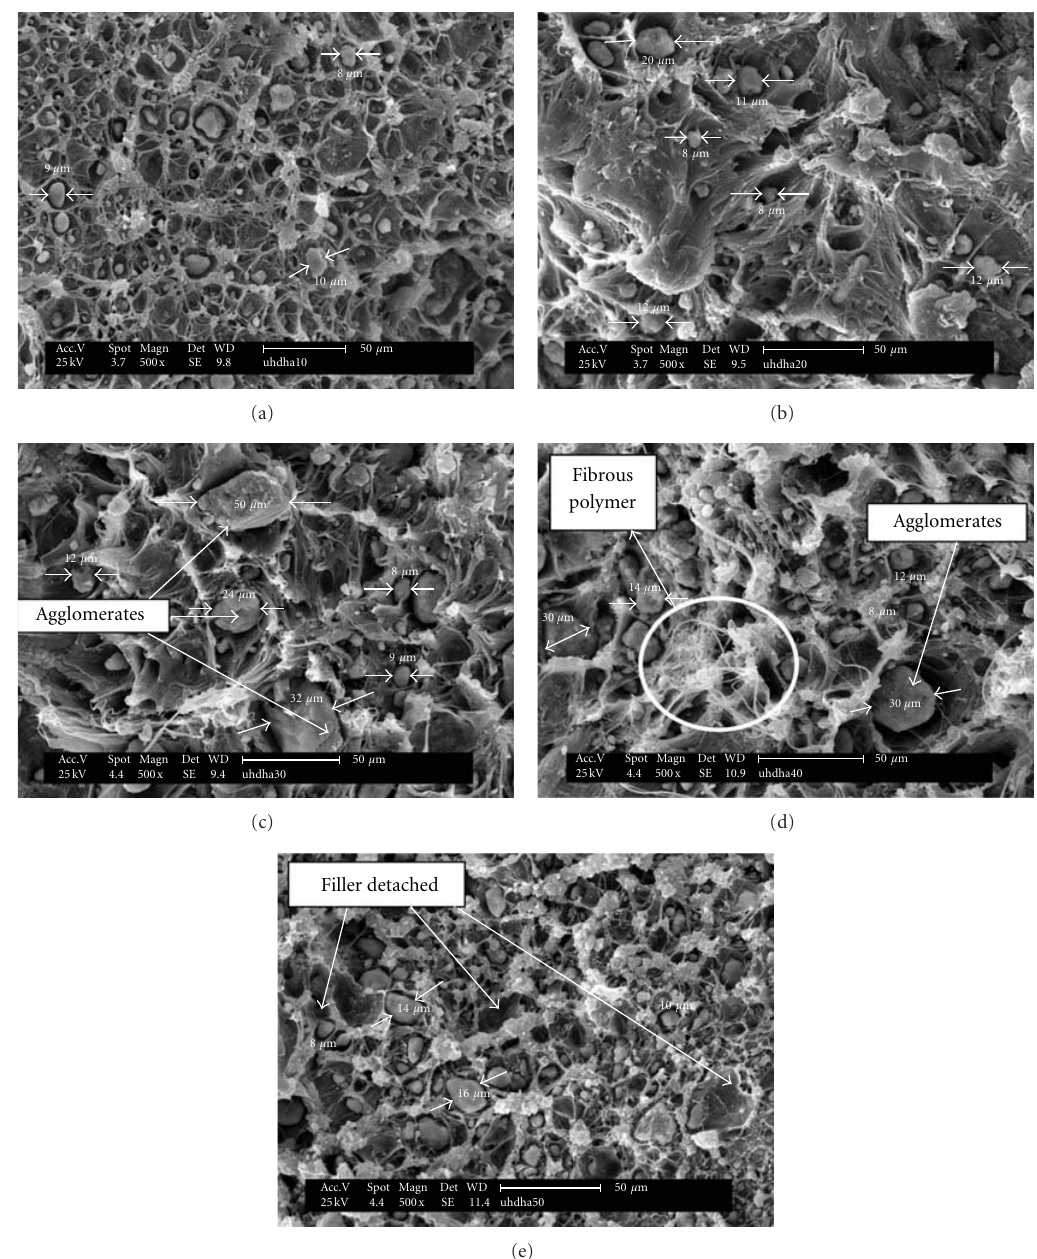
Figure 10: Fracture surfaces of UHMWPE/HDPE/PEG composites for (a) 10, (b) 20 (c) 30, (d) 40, and (e) 50phr HA